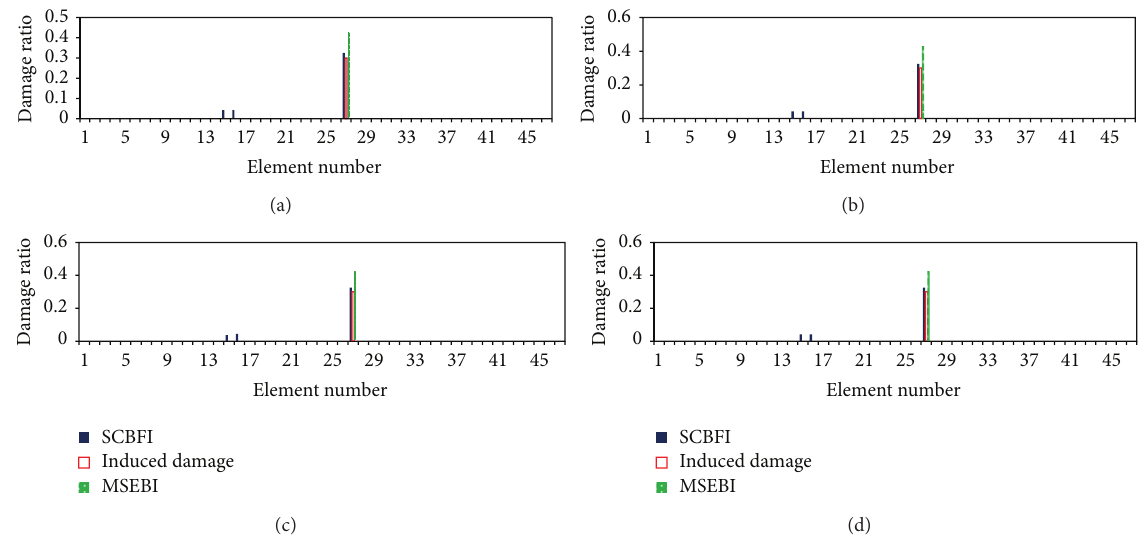
Figure 9: Comparison of damage index SCBFI with MSEBI for 47-bar planar truss for case 1 considering (a) 1 mode, (b) 2 modes, (c) 3 modes, and (d) 4 modes.